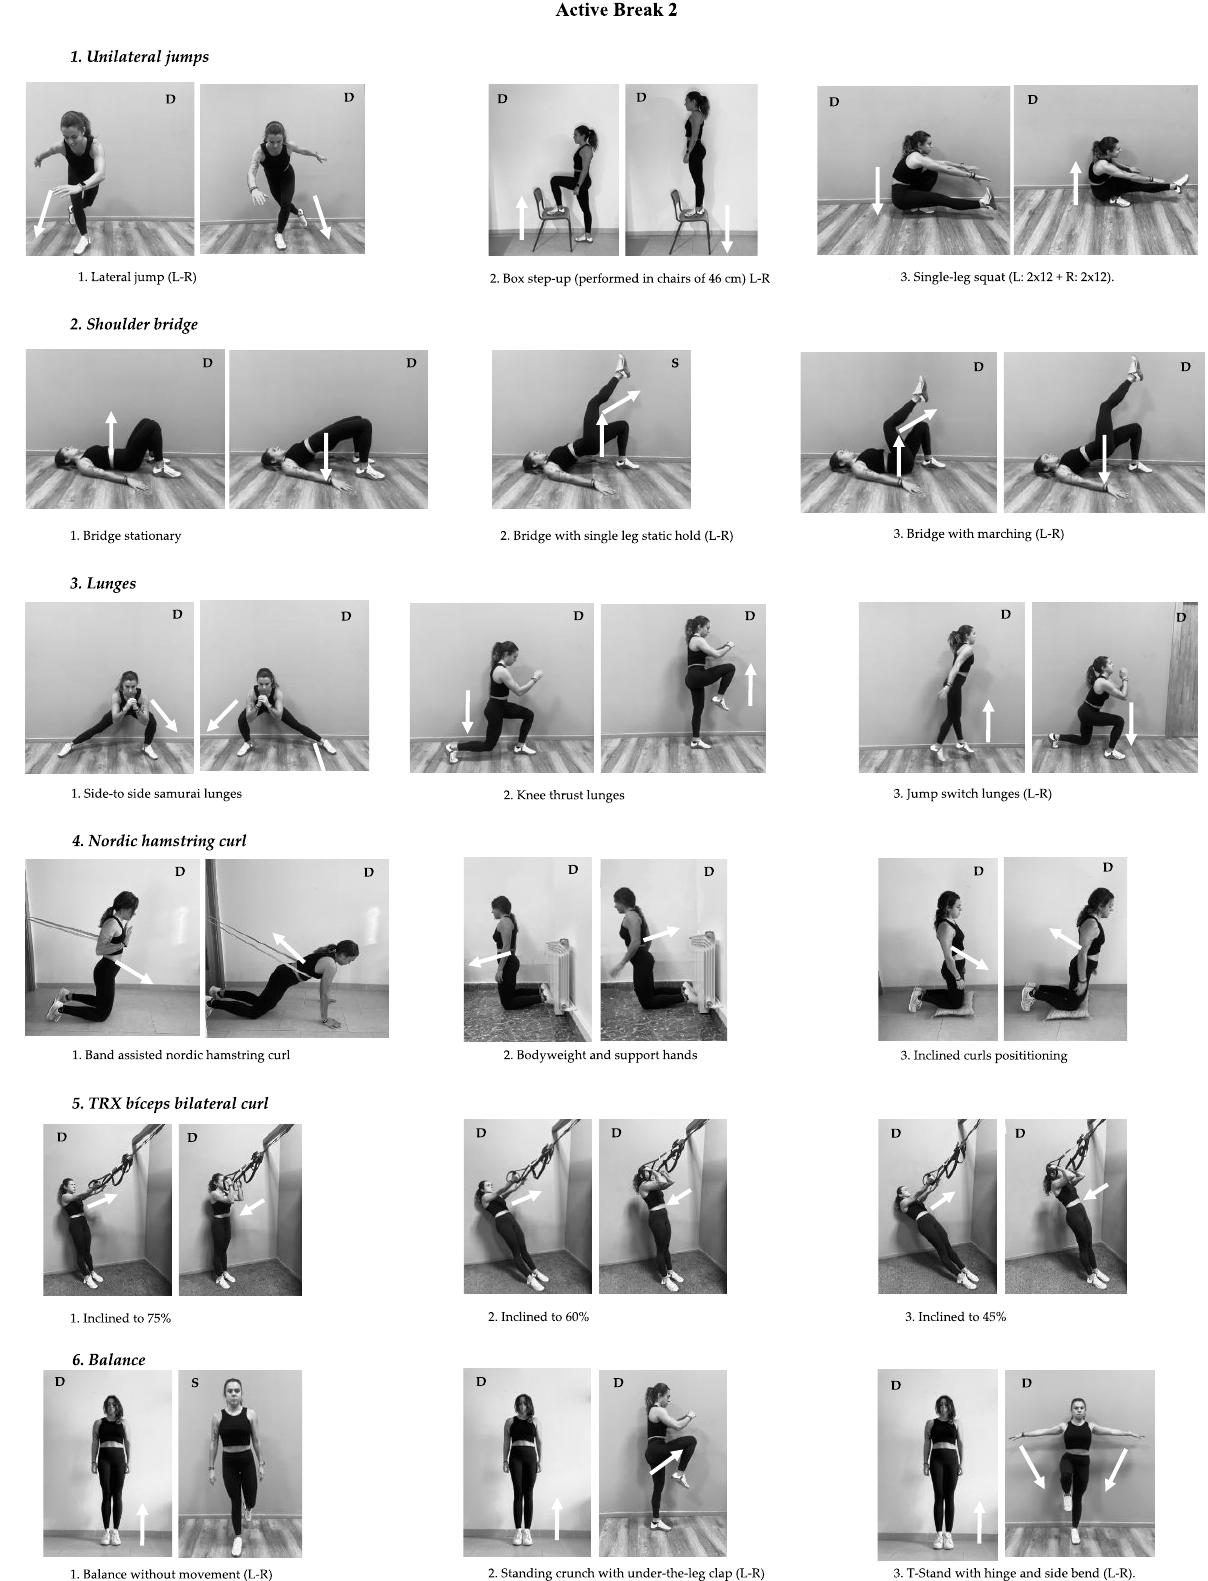
Figure 3. Description of Active Break 2 on high school students. (Arrows represent the movement direction, and S was used for static and D for dynamic movement).